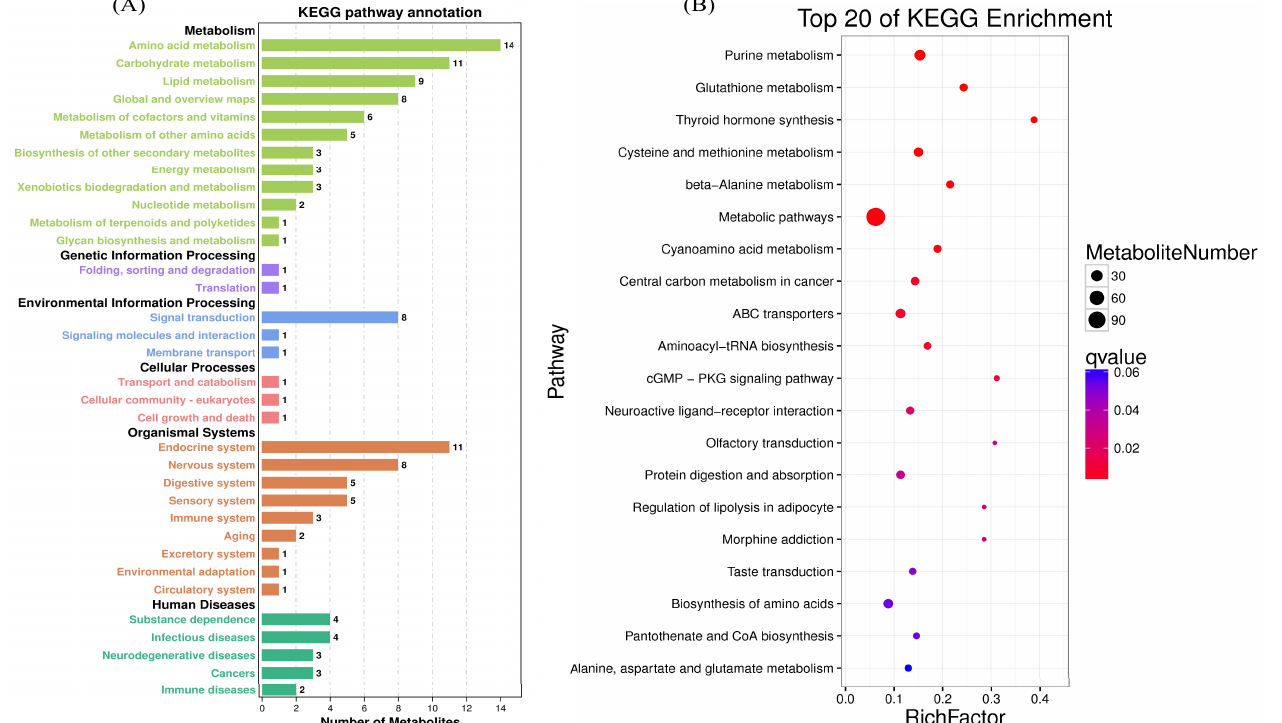
Figure 4. KEGG-pathway-enrichment analysis. Significant differences between different groups: * p < 0.05. ( A ) The KEGG pathway primary classification. The horizontal axis represents the number of differential secondary-level pathways, and the vertical axis represents the pathway. Different colors represent different secondary-level pathways classified by the system. ( B ) The three-level classification KEGG enrichment of top 20 pathways according to the q-value Different colors represent different adjusted q-values, from blue to red, indicating that the adjusted p -values are increasing from large to small, and the degree of enrichment is becoming more and more significant. The size of the dot represents the number of genes enriched in this pathway.